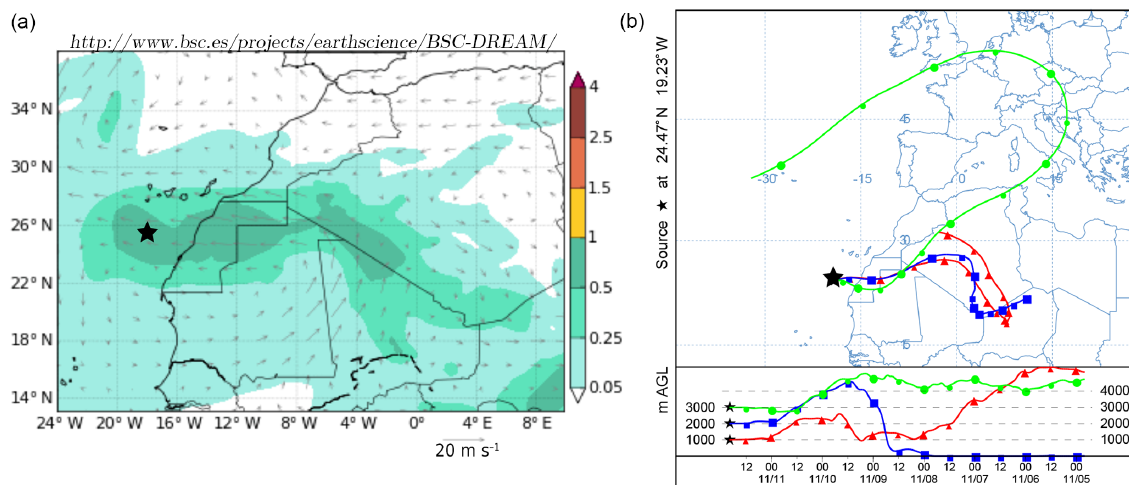
Figure 7. (a) Column-integrated dust concentration (gm 2 ) and 3000m wind on 11 November 2015, 12:00UTC, from the BSC- DREAM8b model (Dust Regional Atmospheric Model), operated by the Barcelona Supercomputing Center (http://www.bsc.es/ess/ bsc-dust-daily-forecast, last access: 14 November 2016). (b) The 7-day NOAA HYSPLIT backward trajectories ending at the position of RV Polarstern on 11 November 2015, 20:00UTC (24.27 ◦ N, 19.23 ◦ W). The position of RV Polarstern is marked by the black